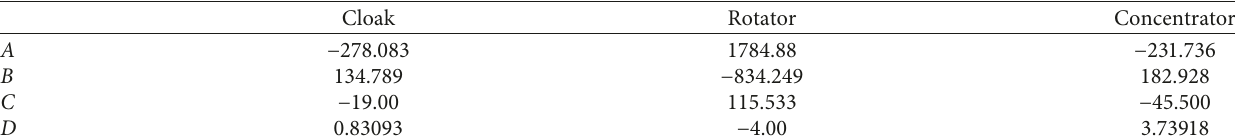
Table 1: Coefficients of third-order polynomial